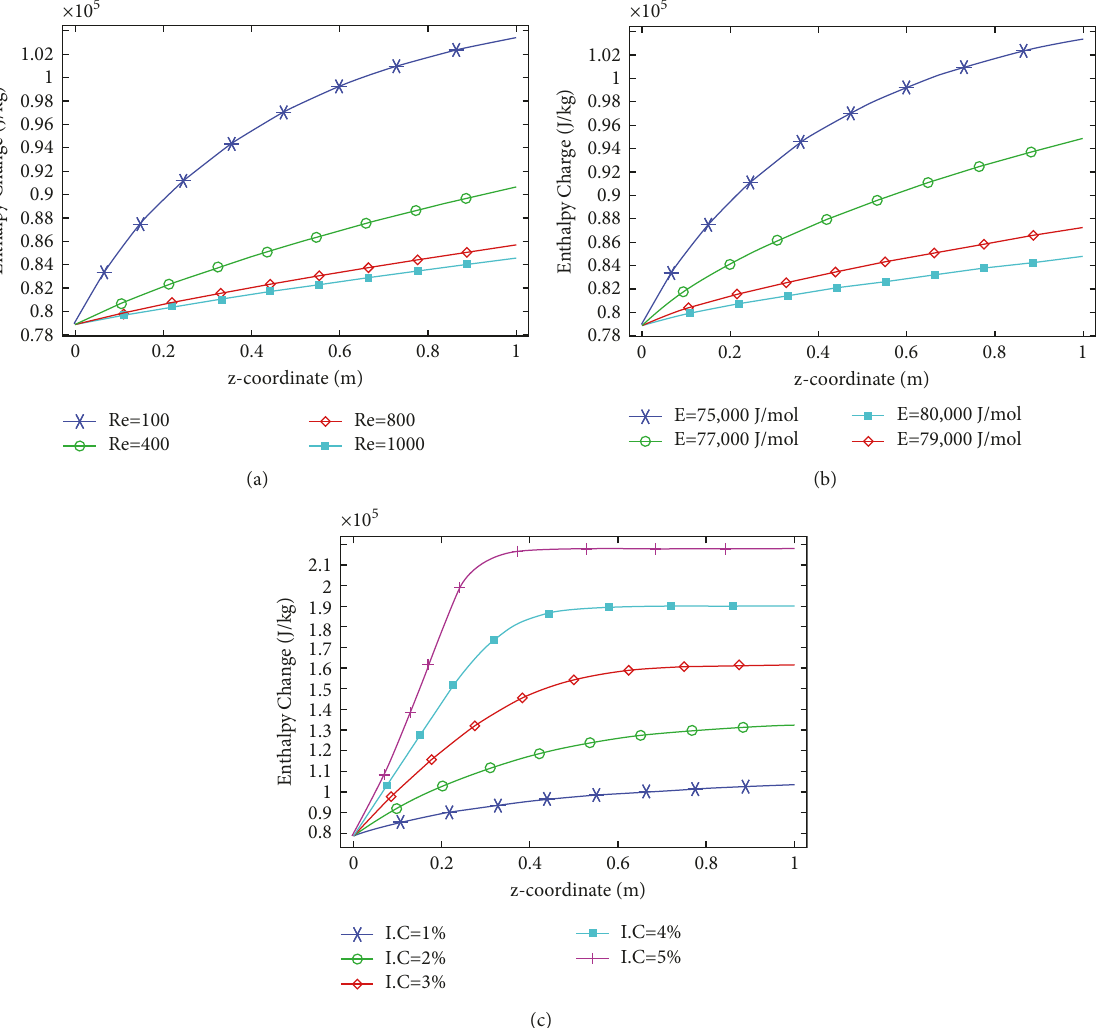
Figure 10: Enthalpy change of the system: (a) I.C � 1%, E � 75,000J/mol; (b) I.C � 1%, Re � 100; (c) Re � 100, E �